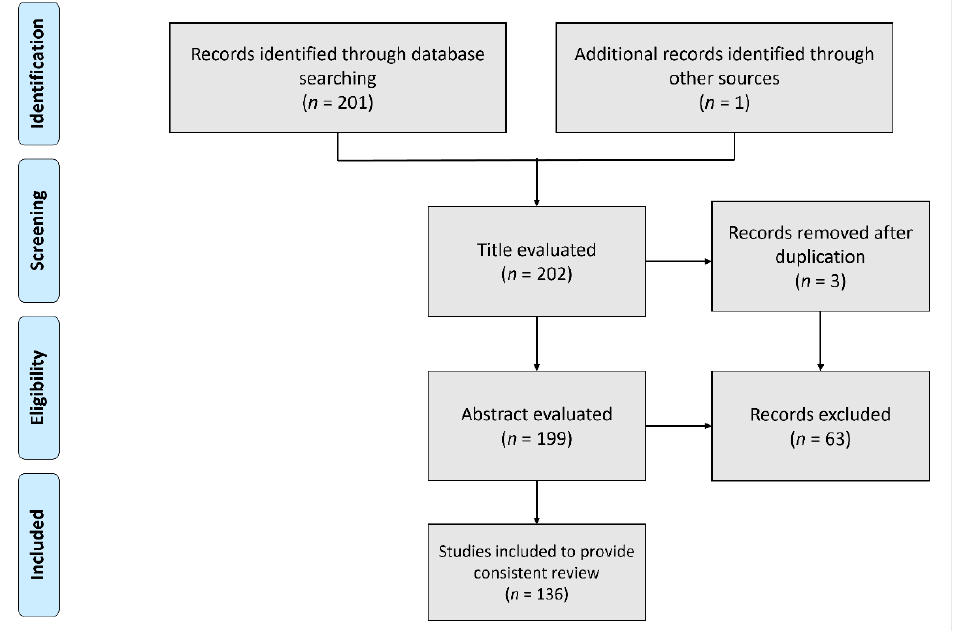
Figure 1. PRISMA flow diagram showing the study selection process.